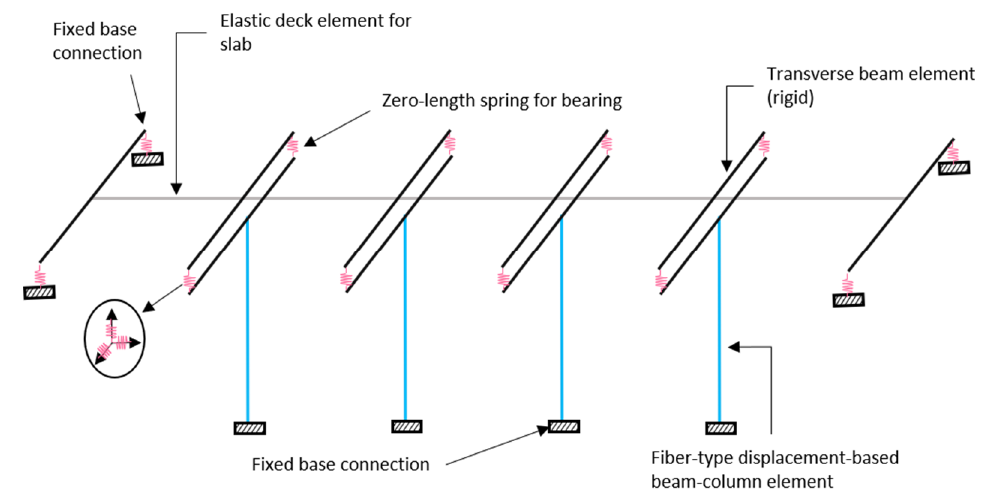
Figure 5. Numerical modeling of the bridge.